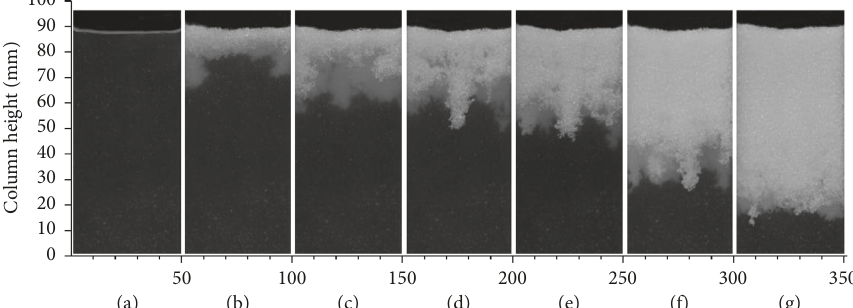
Figure 1: Visualization of the fingering phenomena at the air front through partially saturated transparent soil (9 ∼ 10mm saturated transparent soil was filled into a transparent Perspex column (with the internal cross-sectional area of 50.0 × 50.0mm 2 ) by wet pluviation method, and water profiles were observed at different times during the drainage process: (a) t � 0:0:0, (b) t � 0:33:40, (c) t � 0:38:25, (d) t � 0: